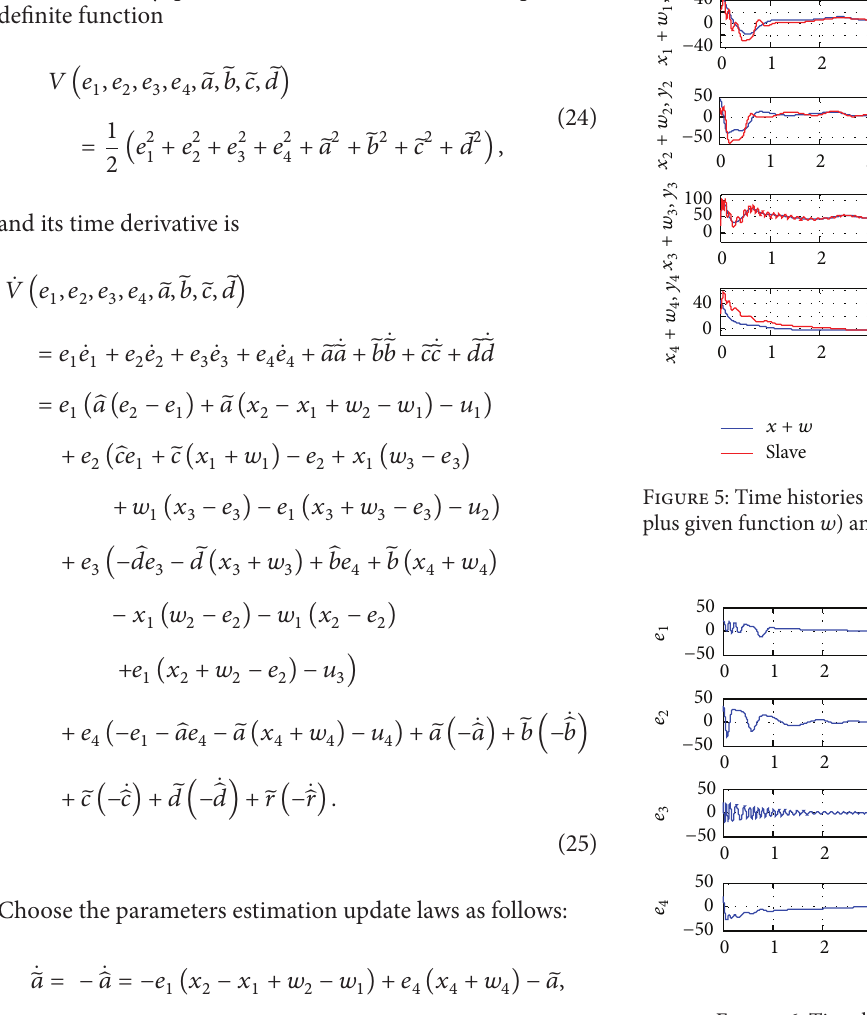
Figure 6: Time histories of error states for Case